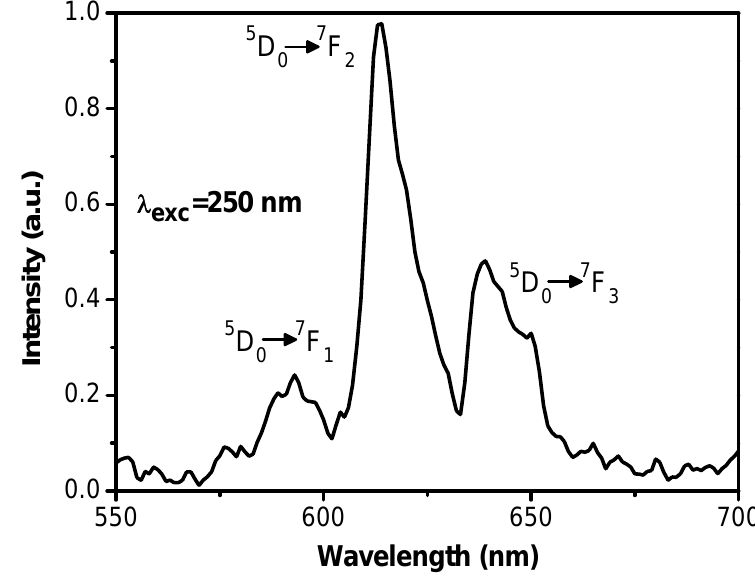
Figure 8. PL emission spectrum of BaTiO excitation. The inset shows a picture of the strong